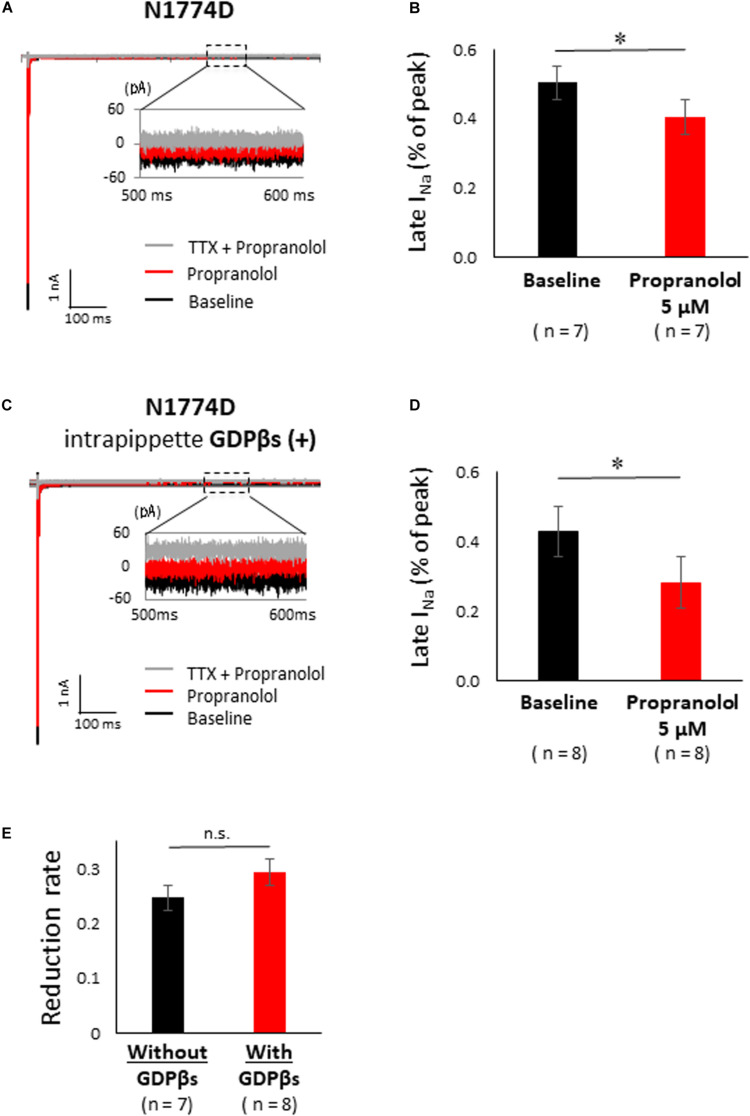
Effect of propranolol on late sodium current in N1774-hiPSC-CMs. (A) Typical late sodium current traces recorded at baseline (black line), after 5 μM propranolol application (red line), and after the additional treatment with 20 μM tetrodotoxin (TTX) (gray line). (B) Statistical analysis of the effect of propranolol on late sodium current. The data pooled from different clones in N1774D-hiPSC-CMs were analyzed. Late sodium current was normalized to peak sodium current. Propranolol significantly reduced the ratio of late/peak sodium current. ∗p < 0.001, vs. baseline. (C) Representative trace of late sodium current in the presence of intrapipette GDPβs. Black line is at baseline, red line is in the presence of 5 μM propranolol, and gray line is in the presence of 5 μM propranolol and 20 μM TTX. We recorded sodium currents in the presence of 5 μM propranolol following addition of 20 μM TTX after recording at baseline. (D) Summary of efficacy of propranolol on late sodium current after intrapipette GDPβs treatment. Propranolol significantly reduced the ratio of late/peak sodium current in the presence of intrapipette GDPβs. ∗p < 0.001, vs. baseline. (E) Reduction rate of late sodium current with and without GDPβs. There is no significant difference between in the absence and the presence of intrapipette GDPβs. GDPβs, guanosine diphosphate βs; TTX, tetrodotoxin.